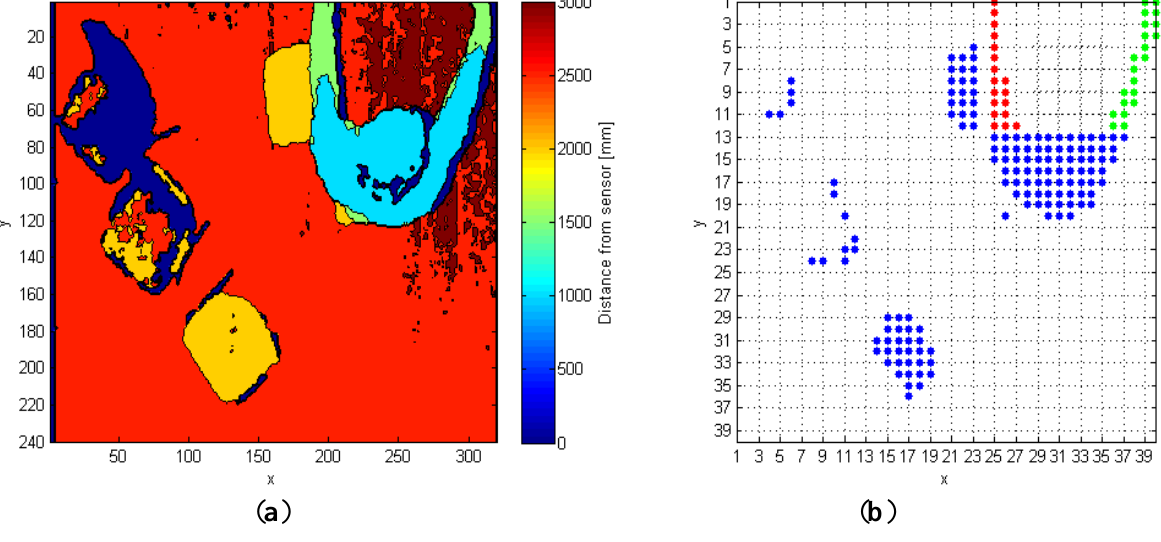
Figure 3. Possible side-effect condition: ( a ) in the DF, and ( b ) in the FF frame, input to distinguish object algorithm. In (b), arms are highlighted with different